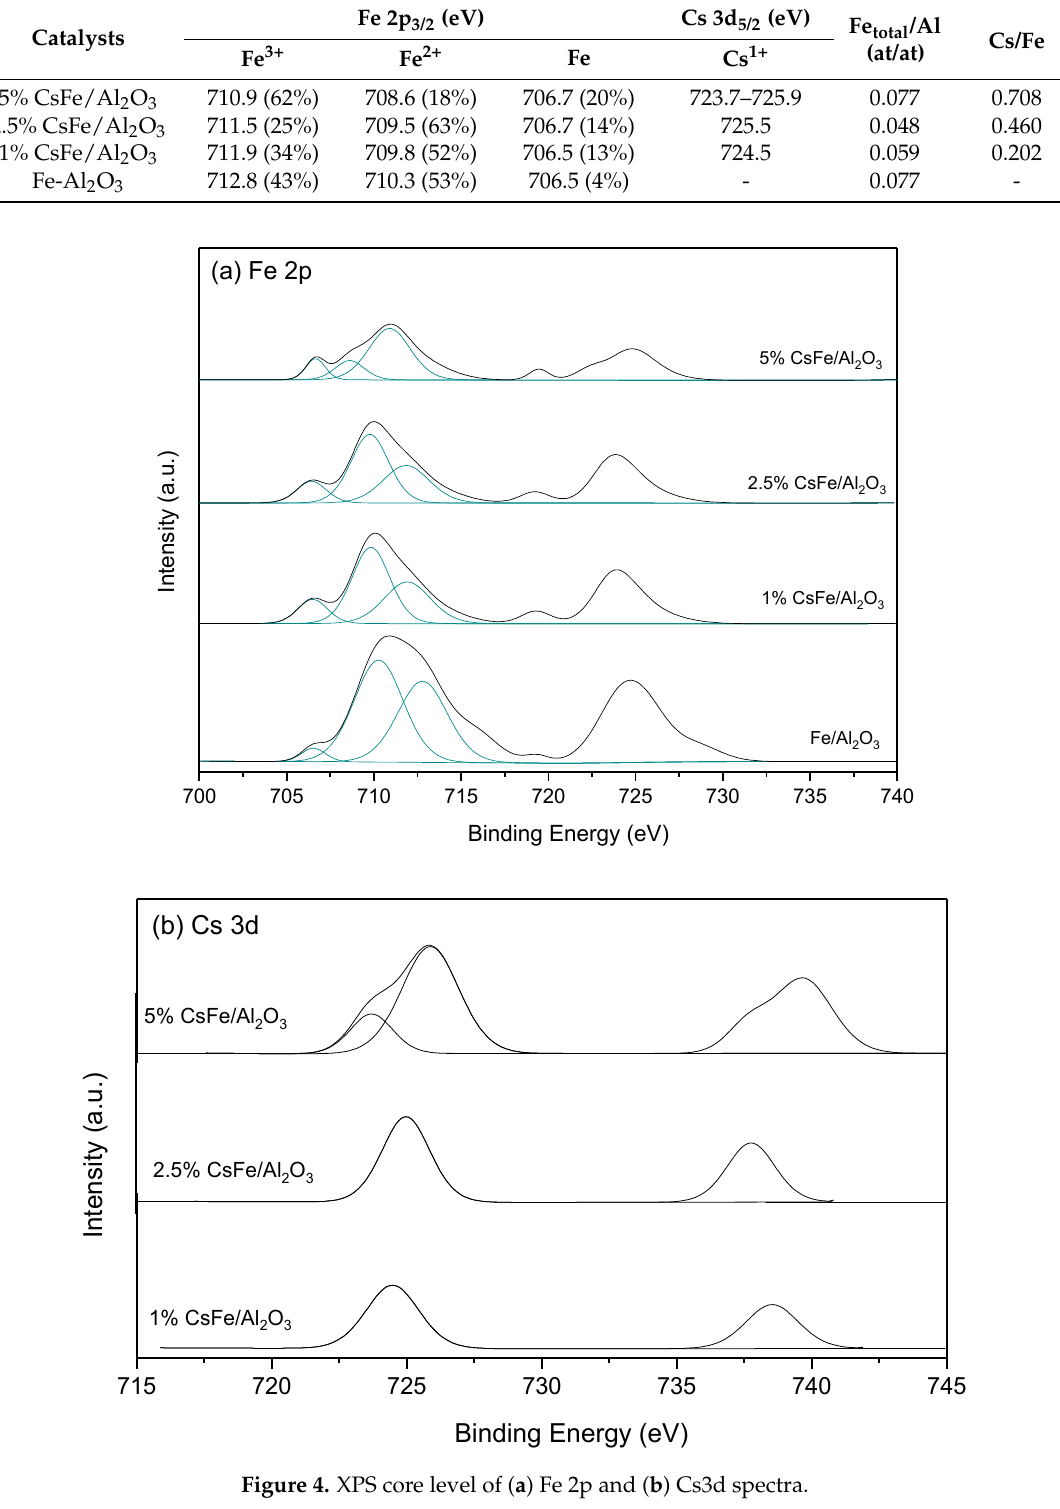
Figure 4. XPS core level of ( a ) Fe 2p and ( b ) Cs3d spectra.